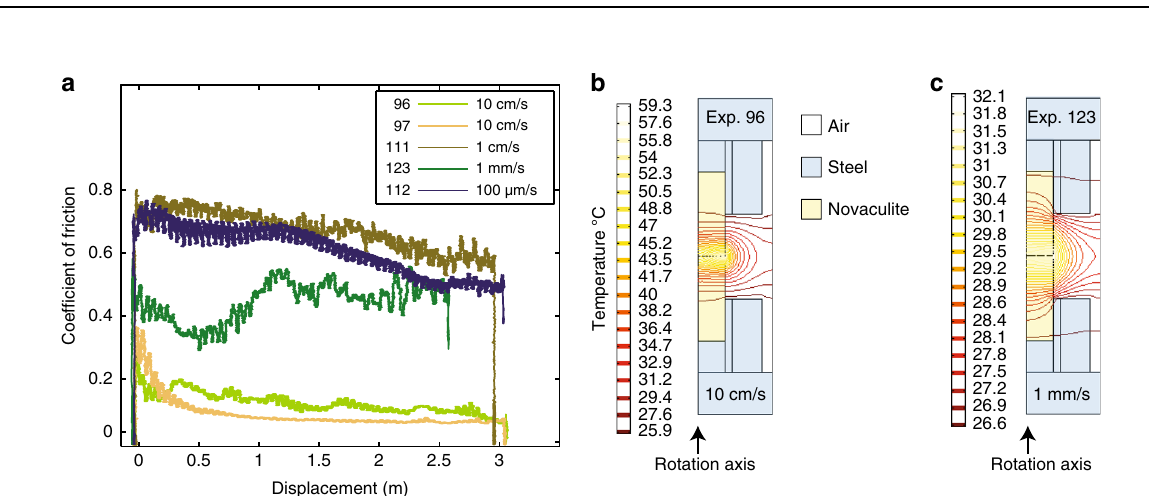
Fig. 1 Results of friction and numerical experiments. a Coef fi cient of friction vs. displacement in novaculite friction experiments. b Temperature distribution from fi nite element model at the end of the experiments for fastest slip rate (10 cm/s, experiment 96) and c slower experiment (1 mm/s, experiment